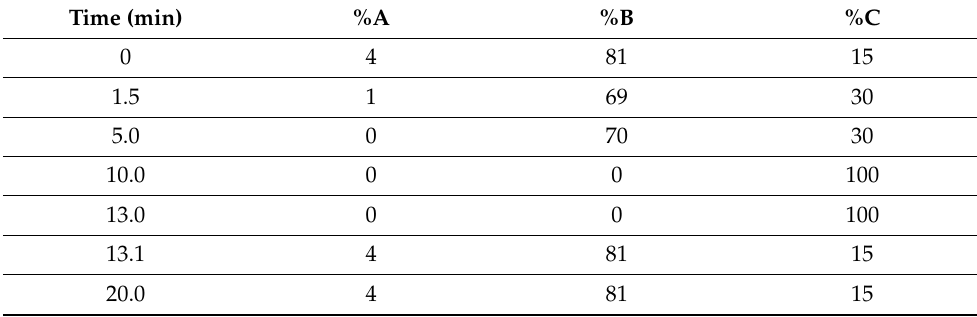
Table 2. Mobile phase gradient used for HPLC–DAD